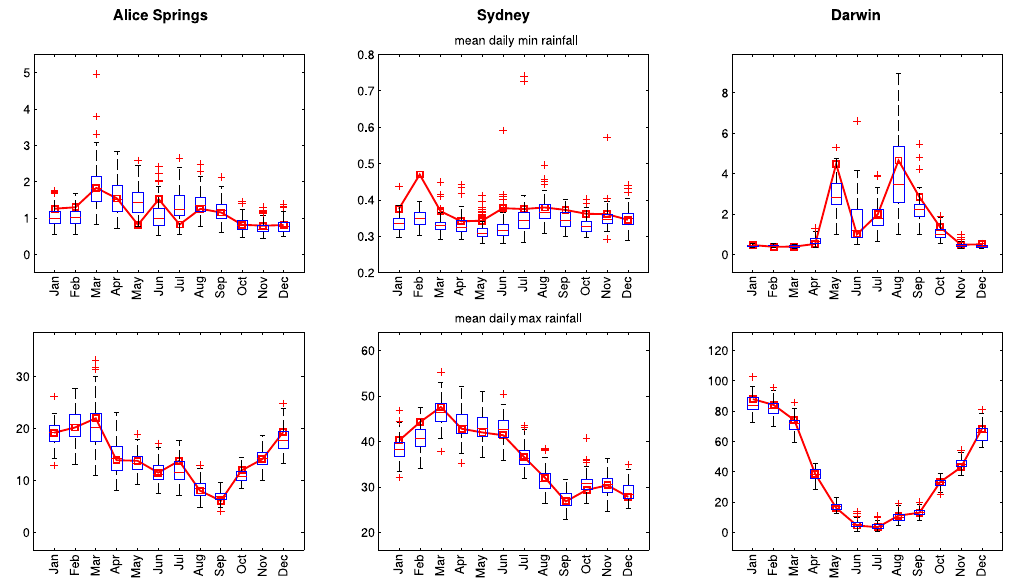
Figure 5. Box plots of the average extremes per month (mm). The solid line indicates the Fig. 5. Box-plots of the average extremes per month [ mm ]. The solid line indicates the reference.